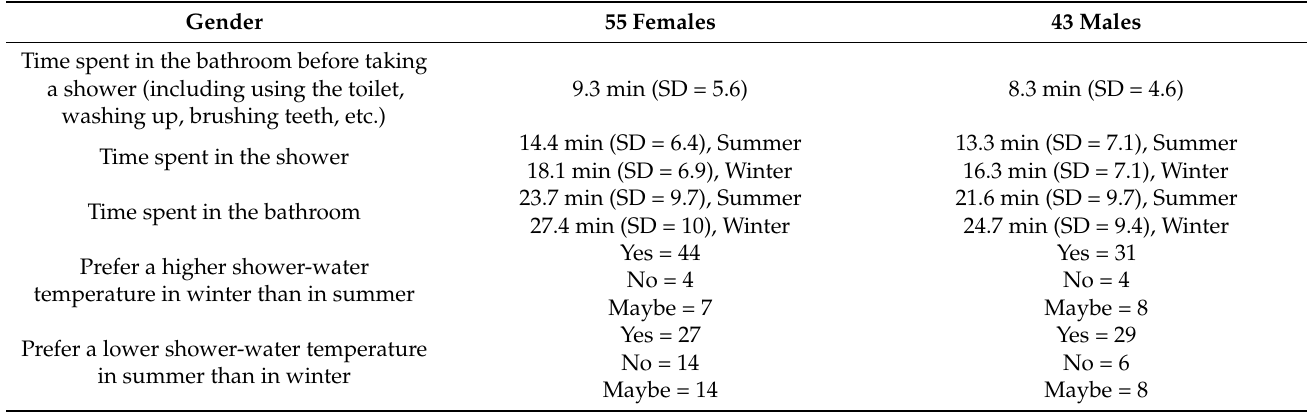
Table 2. Screening interview aspects and